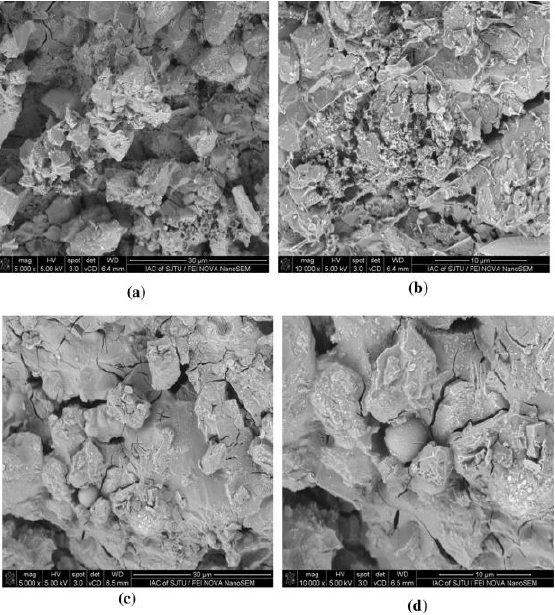
Figure 7 . SEM photographs: ( a , b ) for the sample number 6; ( c , d ) for sample number 11. Reprinted/adapted with permission from Ref. [41]. 2017, Elsevier Science &Technology Journals.